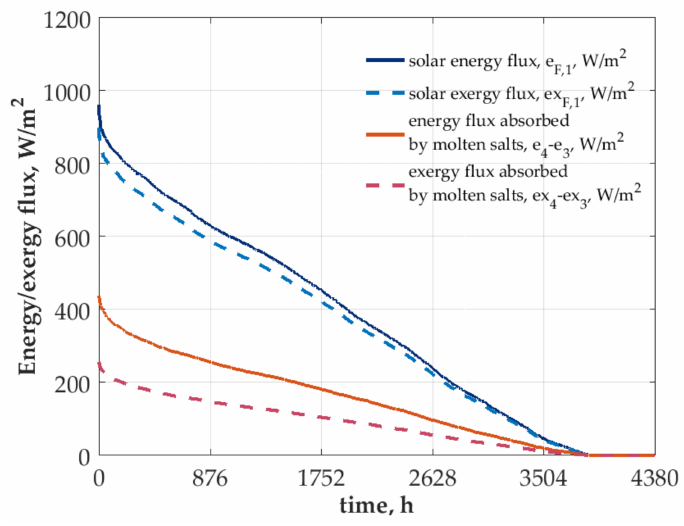
Figure 4. Distribution of the solar radiation energy and exergy during the